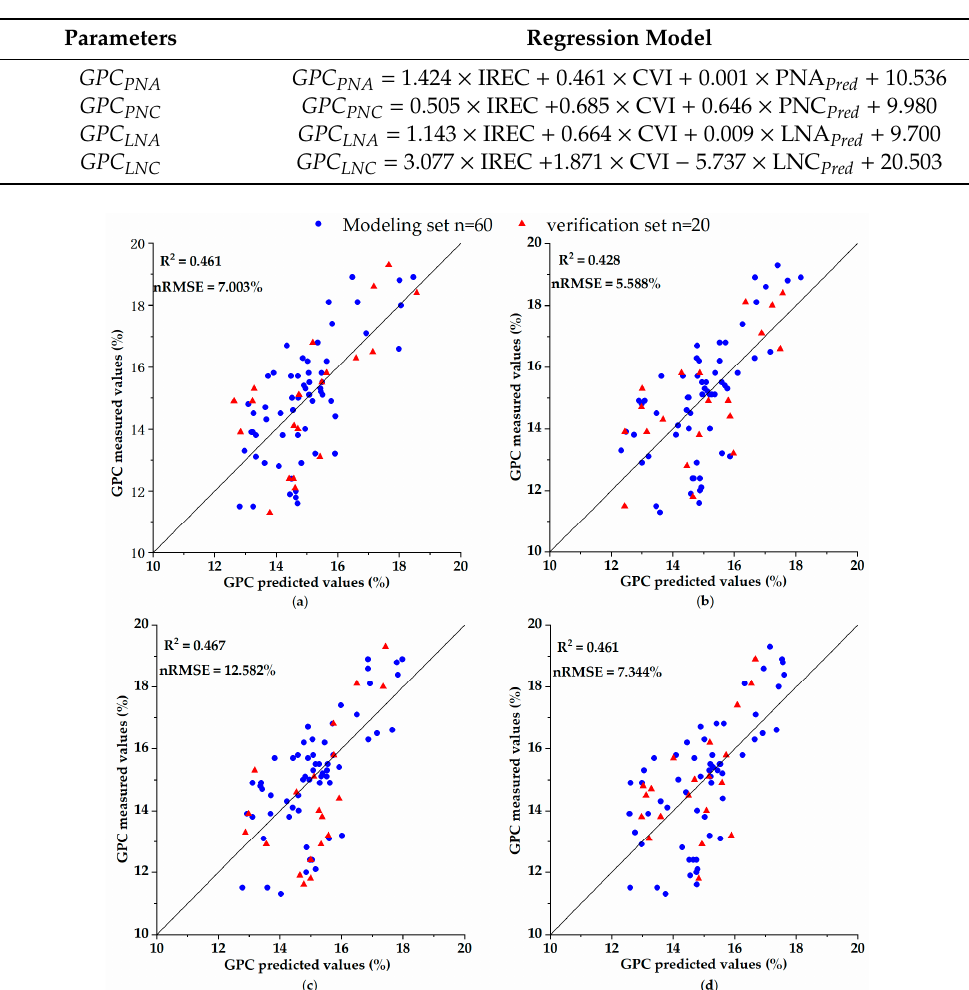
Table 9. Multiple regression models of the wheat grain protein content.